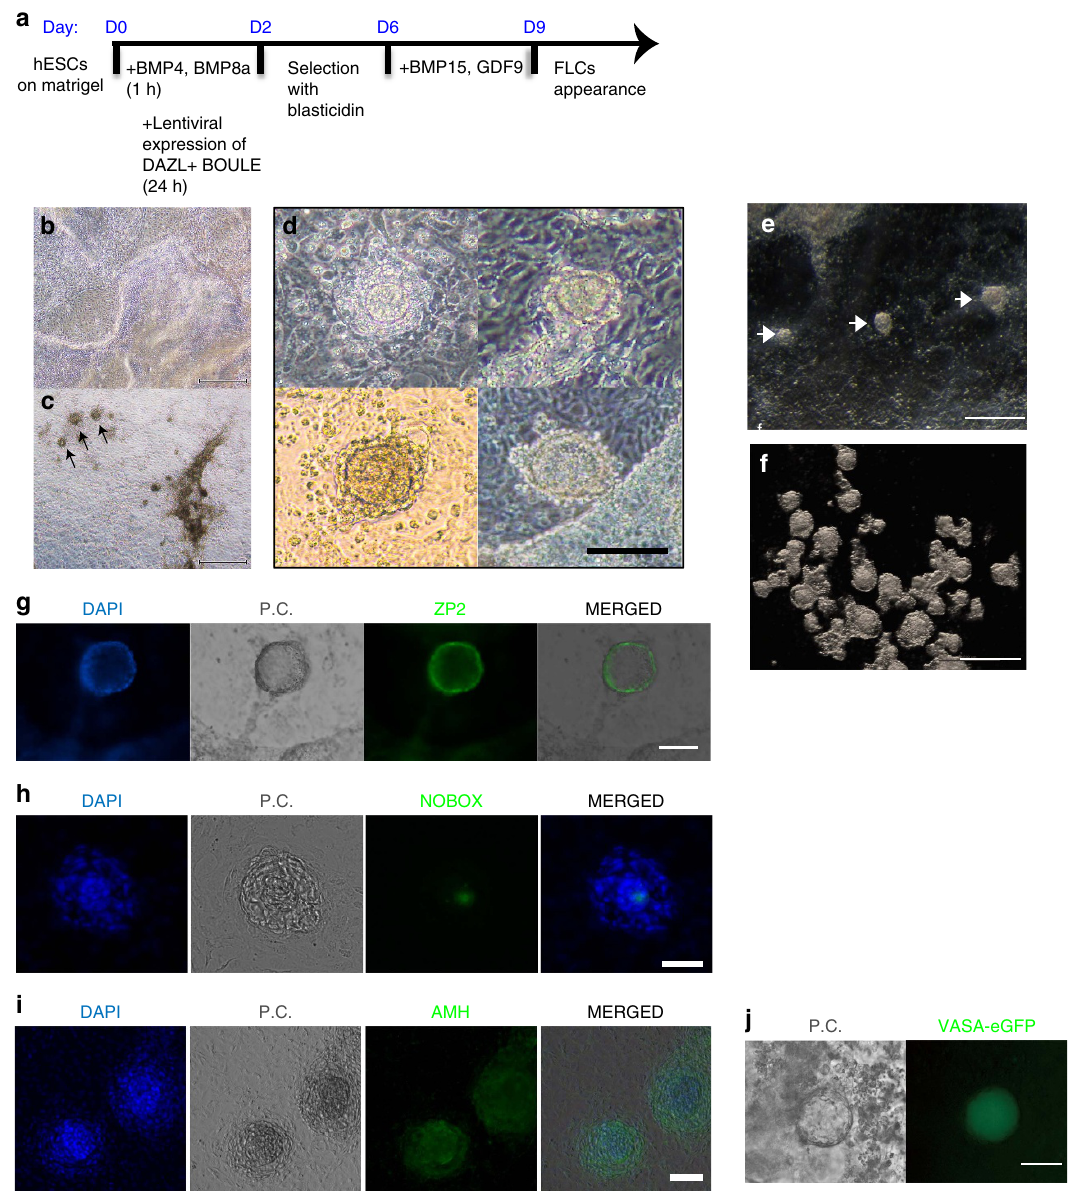
Figure 5 | Appearance of ovarian FLCs induced in differentiated hESCs. ( a ) Schematic timelines and simplified protocols for the differentiation from the undifferentiated hESC stage to the appearance of FLCs. ( b ) Phase-contrast image of a differentiated hESC culture without inducers at day 11. ( c ) Phase-contrast image of a differentiated hESC culture with the inducers described in a at day 11. ( d ) Magnified phase-contrast images of four different FLCs appearing at day 11 in the induced culture. ( e ) Stereo-microscope image of a differentiated hESC culture with inducers at day 11. ( f ) Stereo-microscope image of a group of FLCs collected from a differentiated hESC culture with inducers at day 11. Immunofluorescent staining of ovarian follicle markers ZP2 ( g ), NOBOX ( h ) and AMH ( i ) on the culture plate with FLCs. ( j ) VASA-eGFP reporter cells specifically expressed eGFP in cells that became FLCs. P.C.: phase contrast. Bar, 500 m m in b , c , e , f ; 100 m m in d ; 50 m m in g , h , i , j